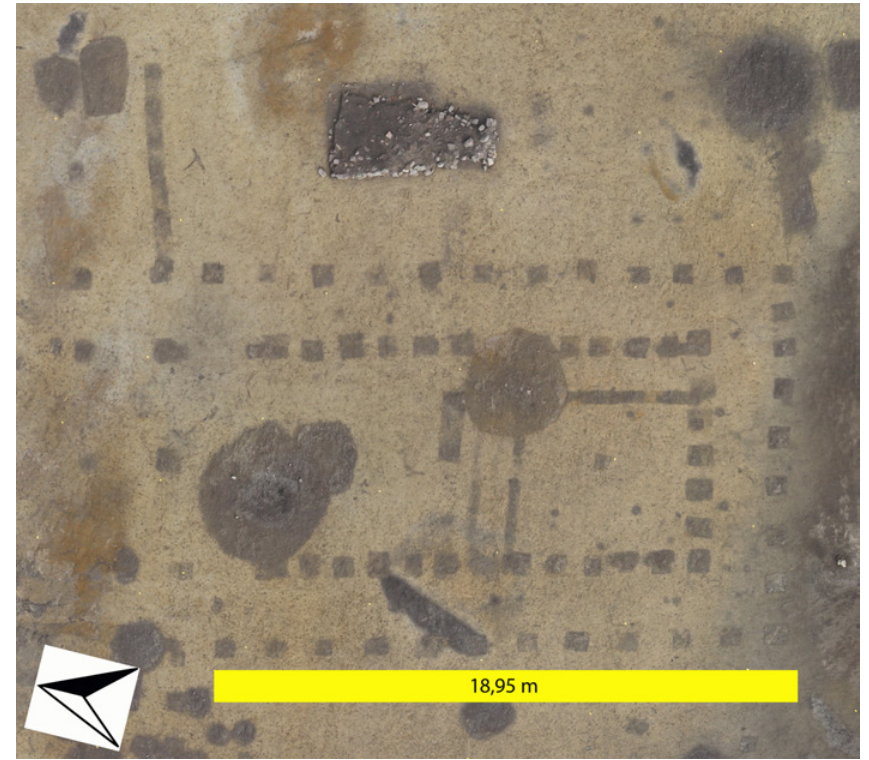
Figure 10: Result of the flights in Neuhofen, Germany.